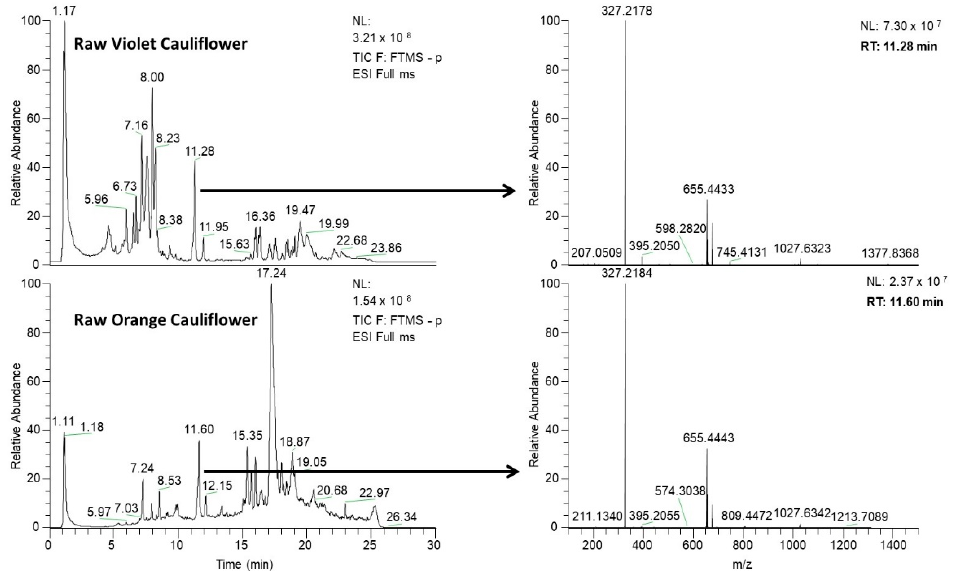
Figure 1. UHPLC–HRMS fingerprints (total ion chromatogram, TIC) for the raw violet and orange cauliflower samples. Full HRMS spectra for each sample fingerprint at a given chromatographic retention time are also depicted.